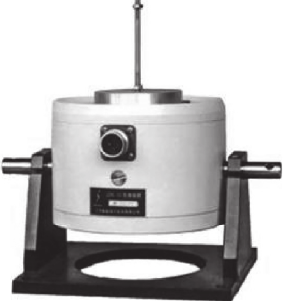
Figure 7: Suspended vibration excitation